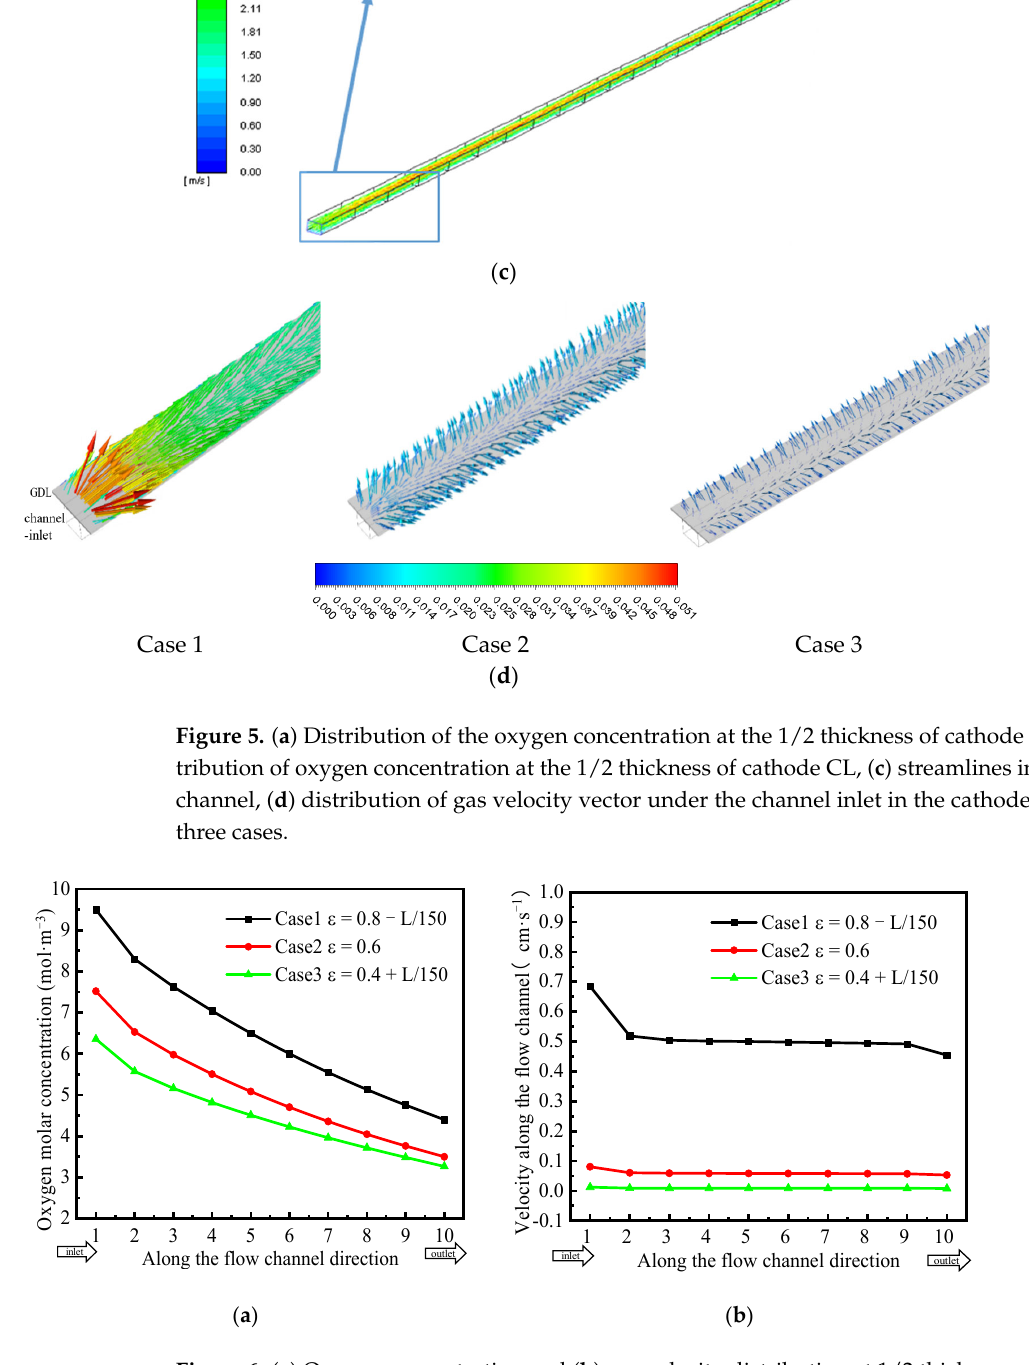
Figure 6. ( a ) Oxygen concentration and ( b ) gas velocity distribution at 1/2 thickness of the cathode